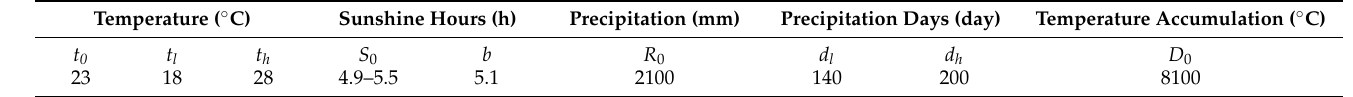
Table 2. Optimum parameters’ values of the comprehensive climatic suitability index model of green orange for optimum planting climate suitable zoning areas in Hainan